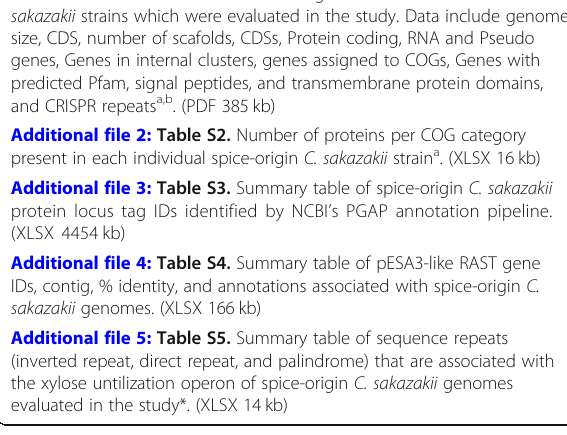
Additional file 1: Table S1. Individual genome statistics of the C. sakazakii strains which were evaluated in the study. Data include genome size, CDS, number of scafolds, CDSs, Protein coding, RNA and Pseudo genes, Genes in internal clusters, genes assigned to COGs, Genes with predicted Pfam, signal peptides, and transmembrane protein domains, and CRISPR repeats a,b . (PDF 385 kb) Additional file 2: Table S2. Number of proteins per COG category present in each individual spice-origin C. sakazakii strain a . (XLSX 16kb) Additional file 3: Table S3. Summary table of spice-origin C. sakazakii protein locus tag IDs identified by NCBI ’ s PGAP annotation pipeline. (XLSX 4454 kb) Additional file 4: Table S4. Summary table of pESA3-like RAST gene IDs, contig, % identity, and annotations associated with spice-origin C. sakazakii genomes. (XLSX 166 kb) Additional file 5: Table S5. Summary table of sequence repeats (inverted repeat, direct repeat, and palindrome) that are associated with the xylose untilization operon of spice-origin C. sakazakii genomes evaluated in the study*. (XLSX 14kb)